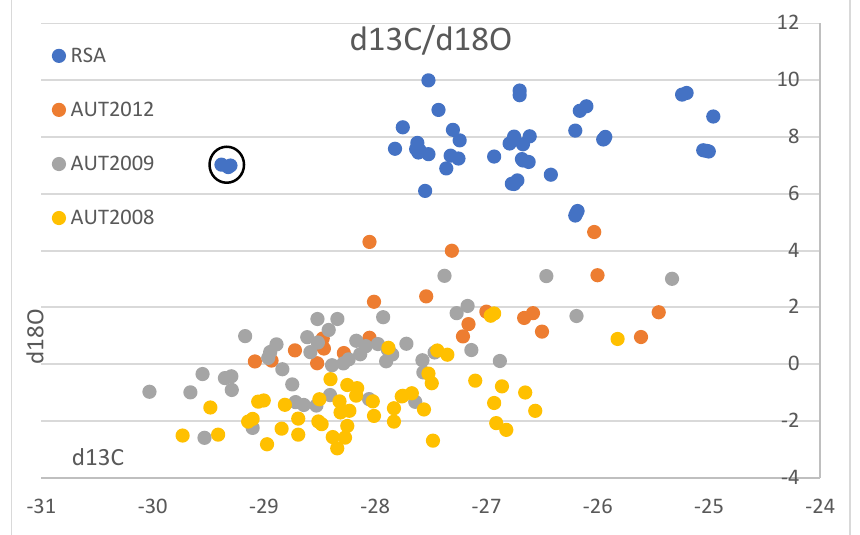
Figure 4. South African wine δ 13 C- and δ 18 O-isotope results and Austrian wine isotope results vintages 2008, 2009 (Horacek et al., 2021 [20]) and 2012 (Griboff et al., 2021 [31]). Values are shown in ‰ versus V-PDB for δ 13 C, and in ‰ versus V-SMOW for δ 18 O. Black circle denotes the South African small-scale vinification sample showing exceptionally low δ 13 C-values. For further explanations refer to text.